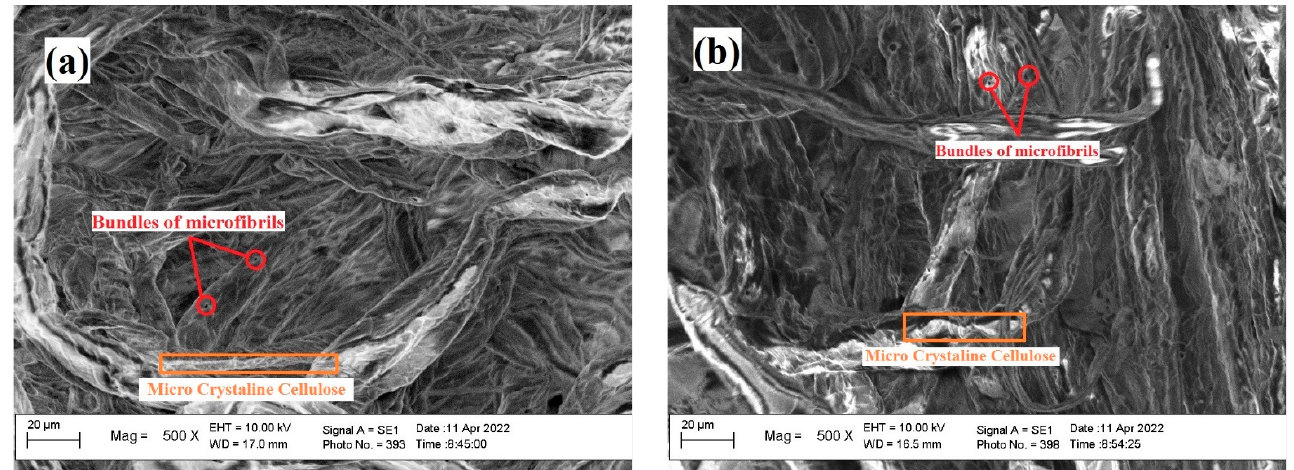
Figure 9. ( a ). Morphological observations using scanning electron microscopy (SEM) on WEFB viscose fibers; ( b ). Morphological observations using SEM on SEFB viscose fibers.